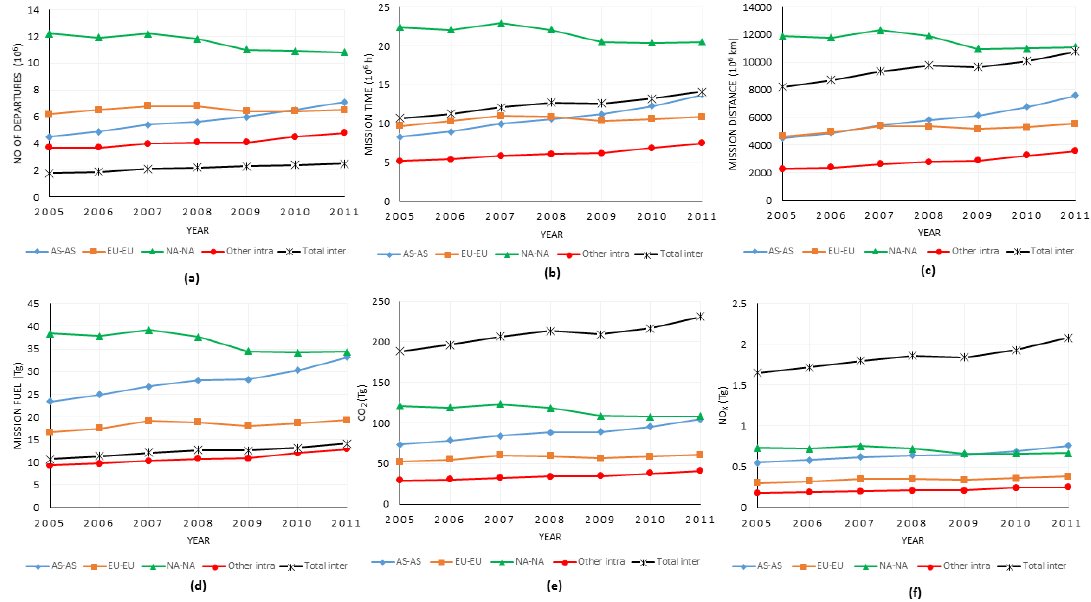
Figure 5. Regional totals of ( a ) the number of departures, ( b ) mission time, ( c ) mission distance, ( d ) mission fuel, ( e ) CO 2 emissions, ( f ) NO x emissions for 2005–2011. Note: Other intra consists of AF Ø AF, CA Ø CA, CB Ø CB, ME Ø ME, SA Ø SA, SW Ø SW. AS, EU, NA, AF, CA, CB, ME, SA, SW represent Asia, Europe, North America, Africa, Central America, Caribbean, Middle East, South America, Australasia, respectively.